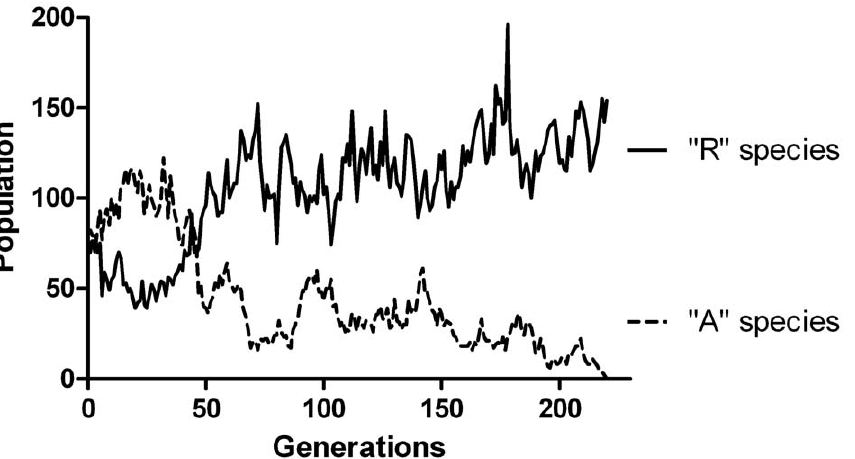
Figure 1. Trajectory of the populations of two species in the stochastic selection model. The species ‘‘R’’ (solid line) and ‘‘A’’ (dashed line) were actually identical because the risk-reward r was set to 1. Both species had a baseline fecundity g 0 =2, i.e. in the absence of risk and competition, each organism would produce a mean of 2 offspring. The population ceiling parameter n max was set to 150. The model was run until one species (‘‘A’’) became extinct, after 220 generations.